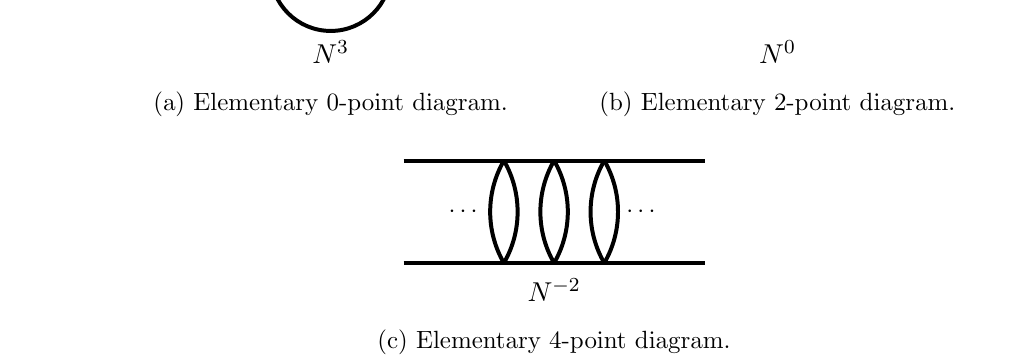
Figure 5. Elementary n -point diagrams.